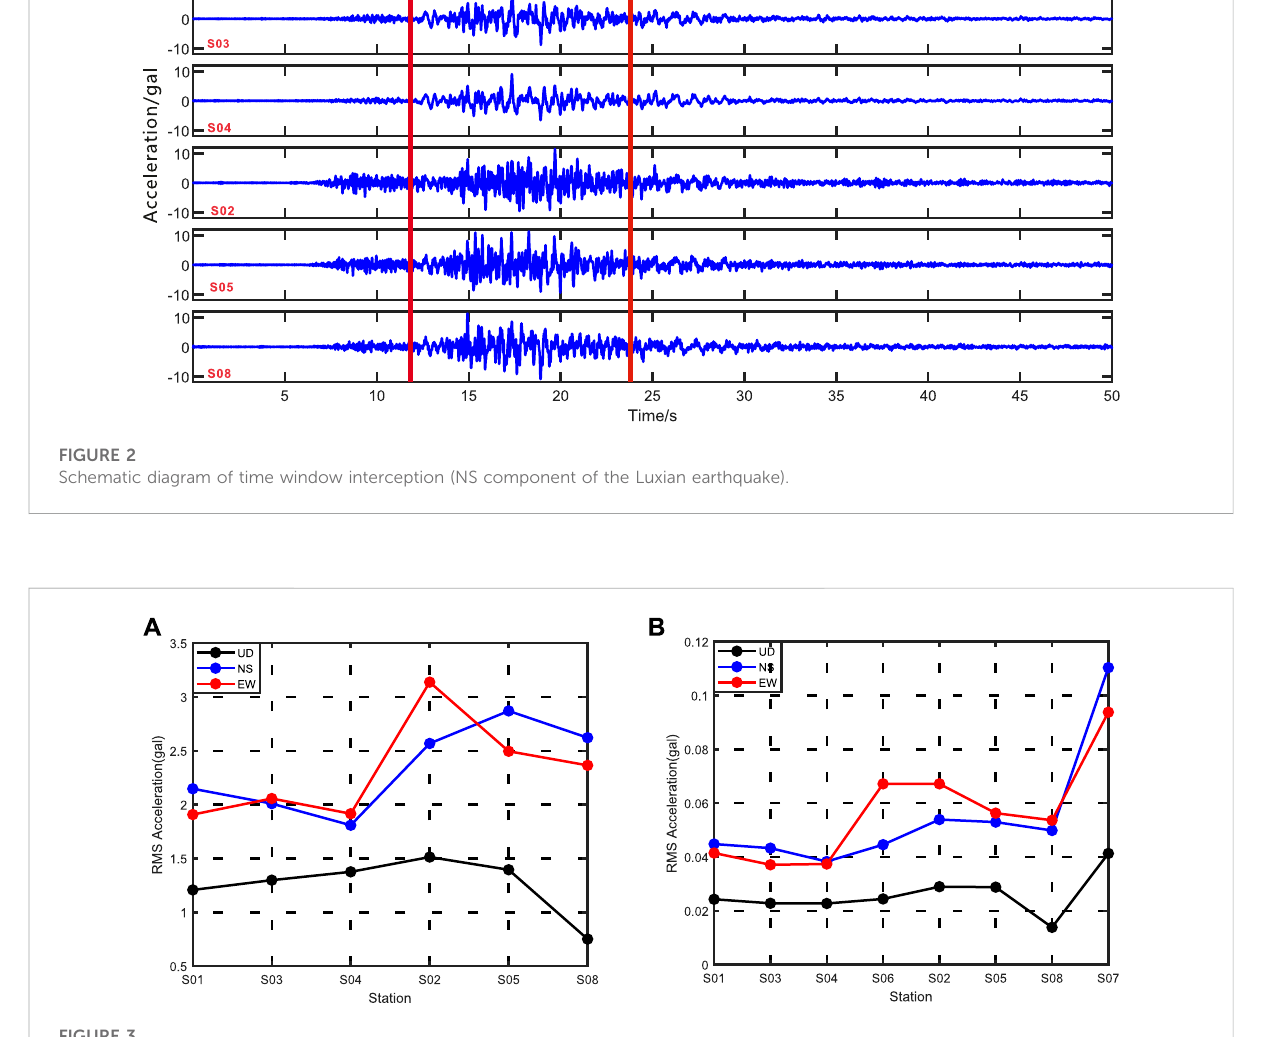
FIGURE 3 Spatial distribution of root-mean-square acceleration: (A) RMS acceleration of the Luxian earthquake; (B) RMS acceleration of the Yibin